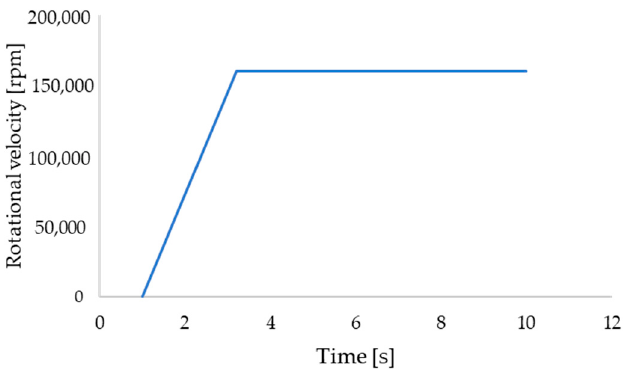
Figure 6. Turbocharger shaft speed variation (experimental result).